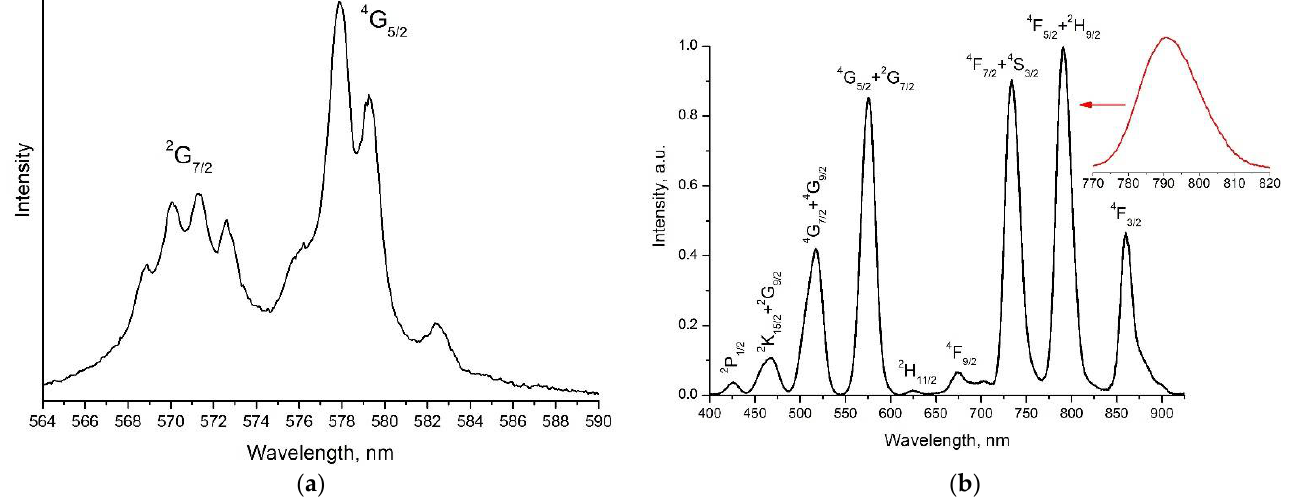
Figure 4. Fluorescence excitation spectrum of the 0.1 at.% Nd 3+ : LaF 3 type I NPs sample detected at 862.8 nm when scanning the laser within the 4 I 9/2 → 4 G 5/2 + 2 G 7/2 transition wavelengths, normalized to the laser energy ( a ) and detected at 1064 nm in the range of 400–925 nm ( b ).